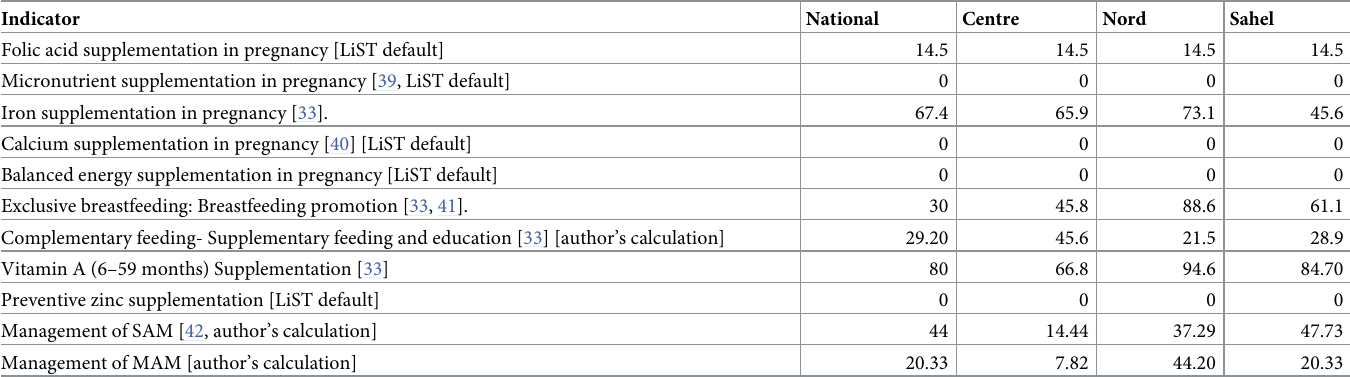
Table 2. Key intervention baseline coverage